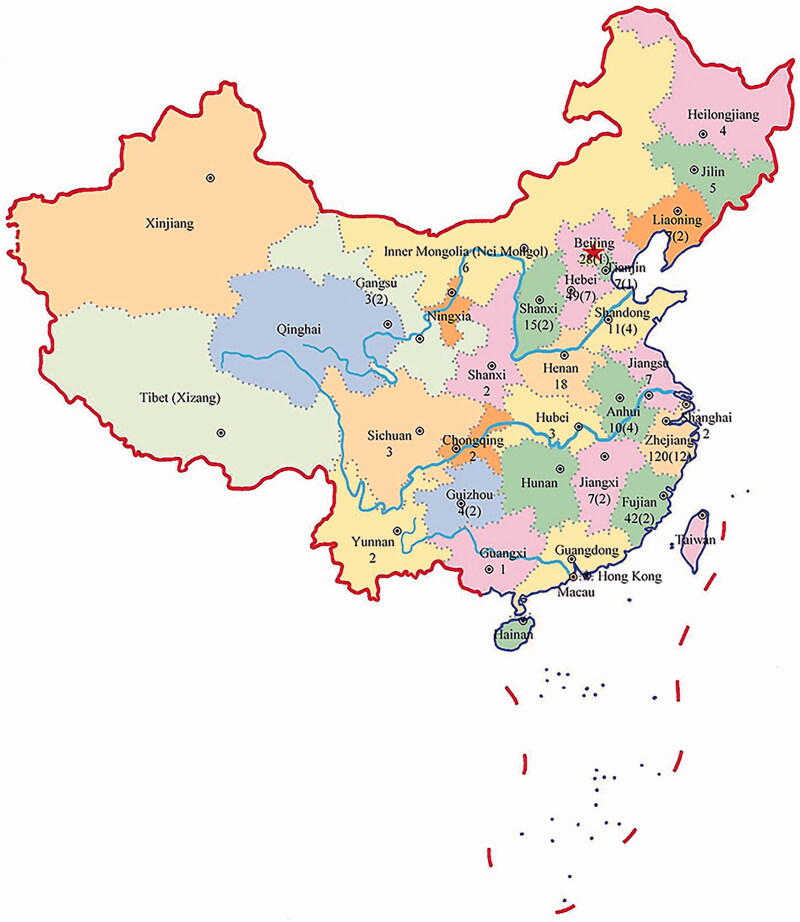
Geographic locations of 352 Han Chinese subjects with LHON. The numbers in parenthesis indicate 41 patients with MT-TT mutations.